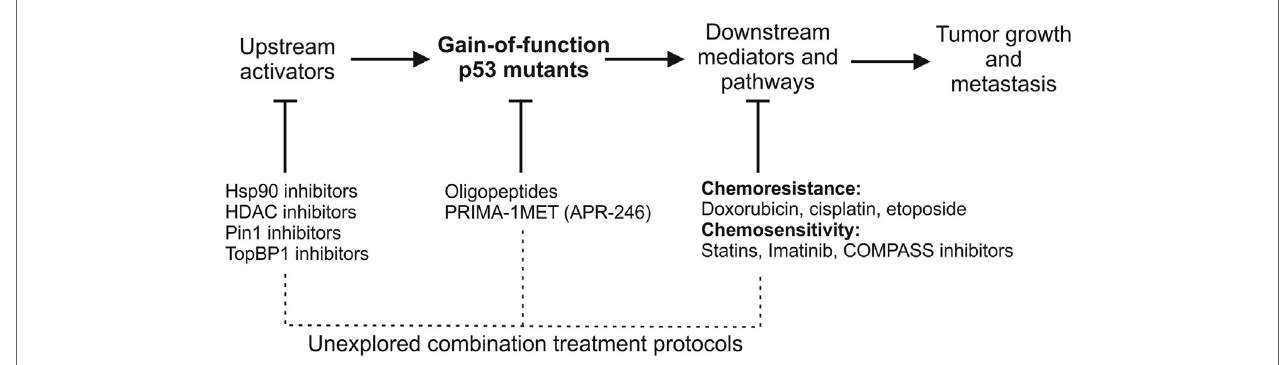
FiGURe 1 | A schematic view of gain-of-function mutant p53 activation, mutant p53 downstream effectors/pathways, and therapeutic opportunities of targeting each of the processes . Below the largely unexplored possibilities of mutant p53-related combinational anti-cancer therapies are